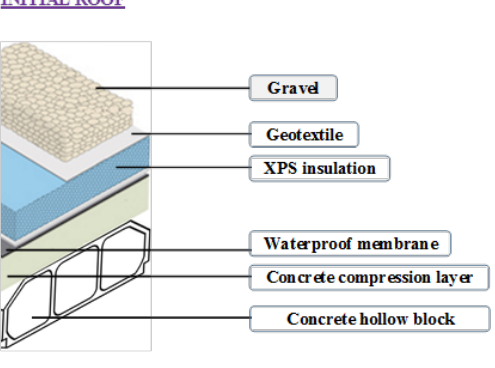
Figure 3. Initial roof structure.